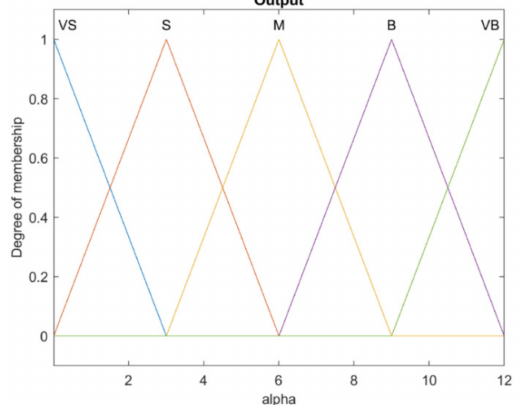
Figure 7. Output membership functions of the slope of sliding surface of α